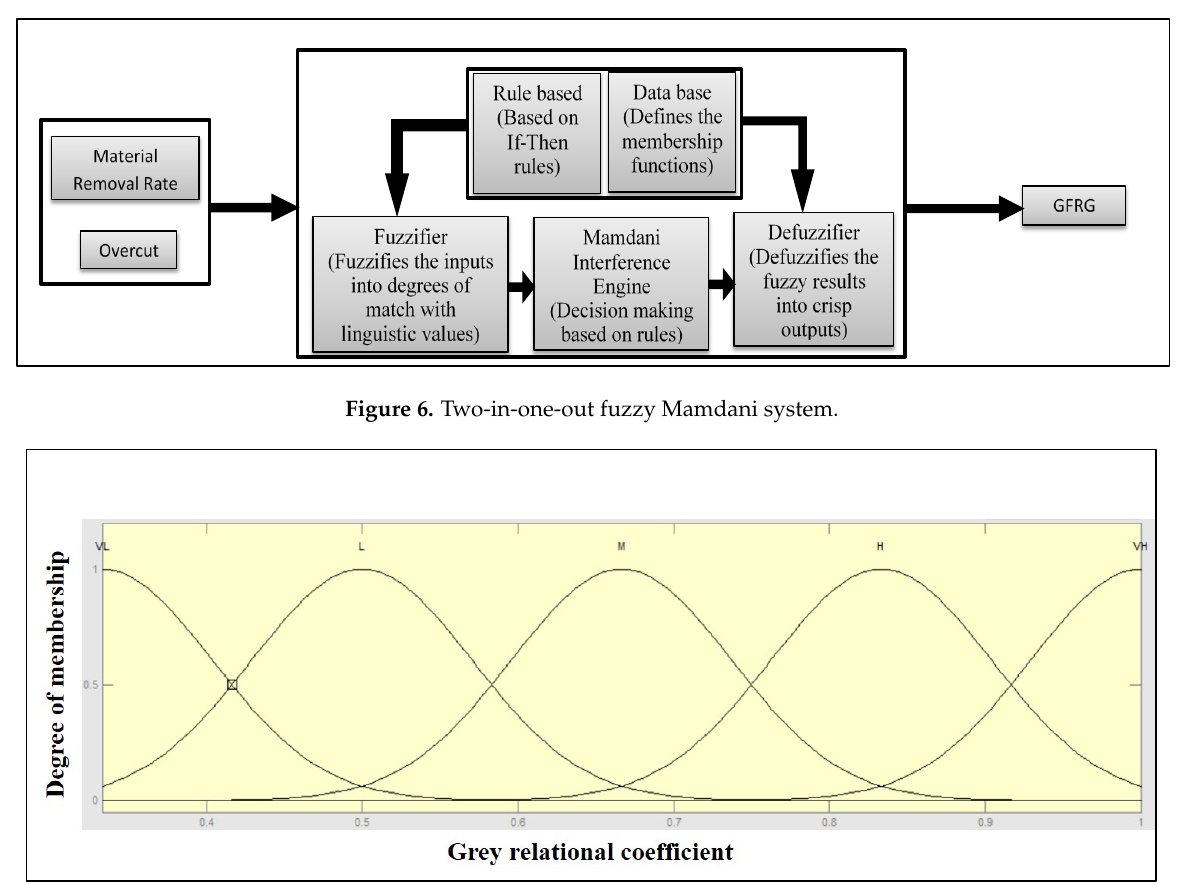
Figure 8. Output GFRG Gaussian function with extremely low (EL), very low (VL), low (L), medium low (ML), medium (M), medium high (MH), high (H), very high (VH), and extremely high (EH). Sixteen rules describing the relations among the GRC (input) and GFRG (output) re- sults were developed based on sixteen sets of experimental trials. The following is an il- lustration of a rule such as this: (GFRG is EL), if (MRR is VL) & (Overcut is VL). A pictorial illustration of these elaborated rules, obtained from the MATLAB tool box of the grey-fuzzy system, is shown in Figure 9a,b. The fuzzy rules generated depending on the sixteen groups of experimental runs are represented by the rows in Figure 9b, while the first two columns display the input GRC results for the two-response variable, and the